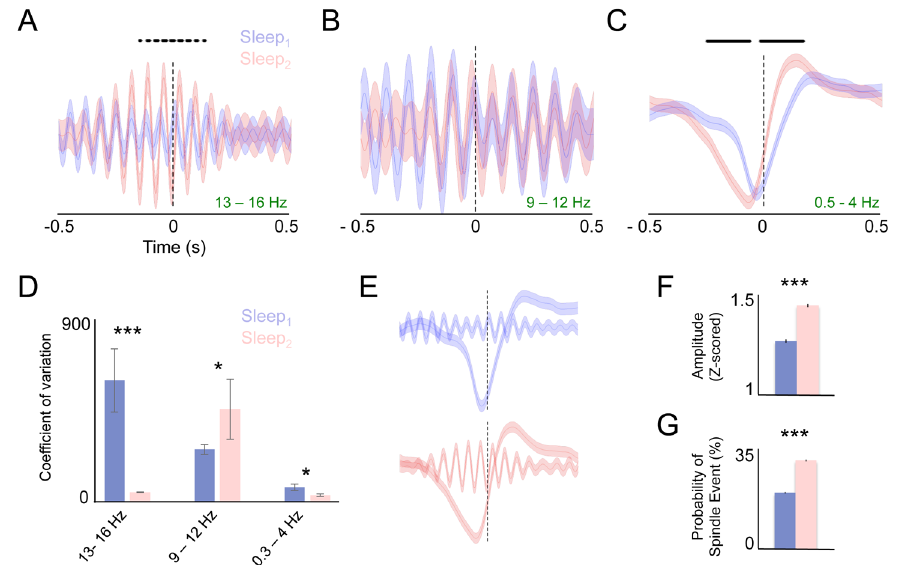
Fig 6. Relationship of ensemble reactivation to NREM oscillations. (A) Event-triggered z-scored LFP for fast-spindle oscillatory frequencies filtered at 13 – 16 Hz. Post-hoc differences ( p < 0.05) indicated by points above graph. (B) Event-triggered LFP for slow-spindle frequencies (9 – 12 Hz). There were no significant differences across any time point. ( C) Event-triggered LFP for slow oscillation frequencies (0.5 – 4 Hz). (D) Comparison of the coefficient of variation (CV) for each oscillatory band. For fast spindles and slow oscillations, for each point that was significantly different between the two groups, we compared the CV. After learning, the CV was significantly reduced, suggesting more consistent temporal locking after learning. For slow-spindle oscillations, because no points were different between the two groups, we instead used the points that were significantly different in the fast-spindle frequency. (E) Comparison of the z-scored temporal coupling between reactivation-triggered slow wave and fast-spindle oscillation before and after learning. (F) Changes in mean event-triggered spindle amplitude. We calculated the instantaneous analytic amplitude of the fast spindles at the slow-wave trough for each reactivation. There was a significant increase in spindle amplitude. (G) Increase in the probability that a reactivation event was associated with a fast-spindle oscillation. Error bars show S.E.M. * p < 0.05, ** p < 0.01, *** p <